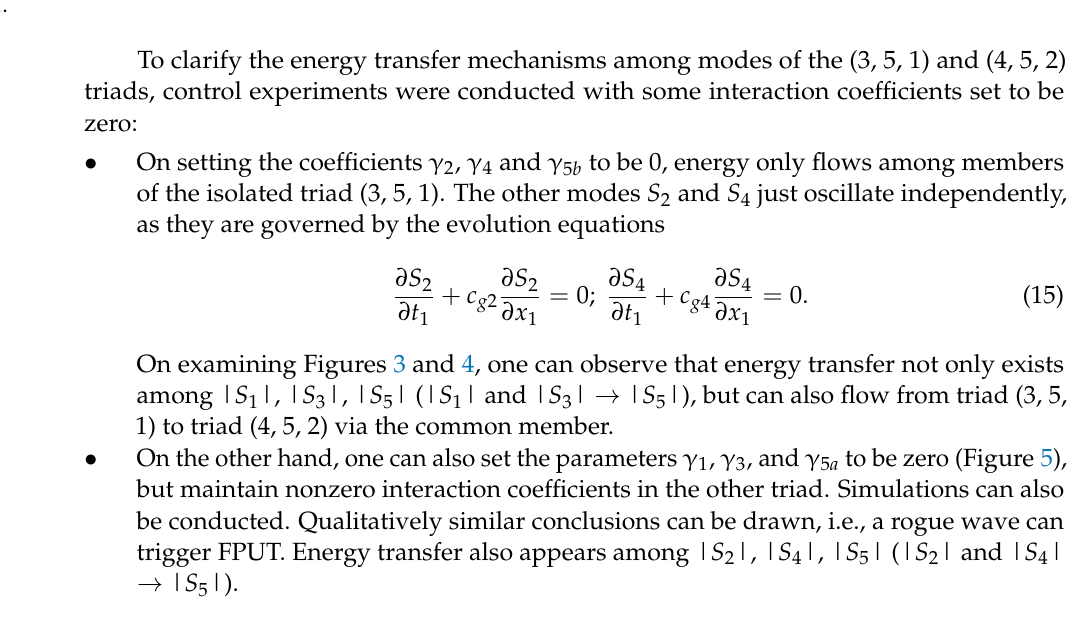
Figure 3. ( a – e ) Evolution of the five wave components; ( f ) time history of the moduli of the envelopes, | S k |. Parameters used were c g 1 = 2, c g 3 = 1, c g 5 = 0.5, c g 2 = 0.1, c g 4 = 0.1, γ 1 = − 0.1, γ 3 = 0.1, γ 5 a = 0.1, γ 2 = − 0.1, γ 4 = 0.1, γ 5 b = − 0.01, r 1 = 1, r 2 = 1, r 3 = 0, q = 1, a 2 = 1, ρ ρ ρ ρ ρ 1 = 2 = 3 = 4 = 5 =